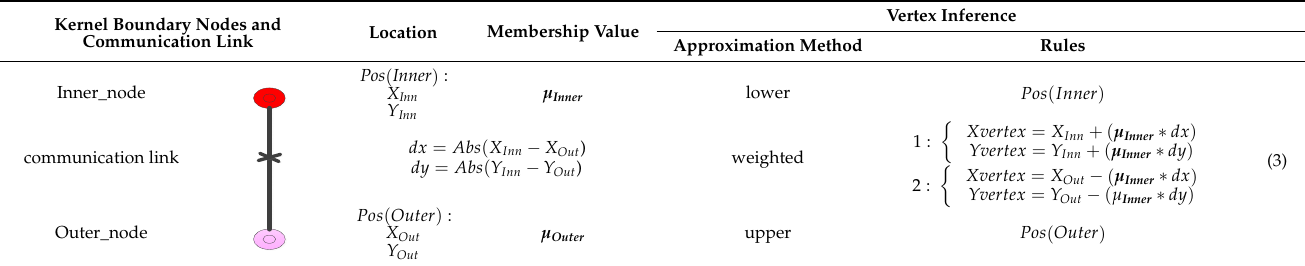
Table 3. Example of fuzzy rules for vertices inference of a kernel